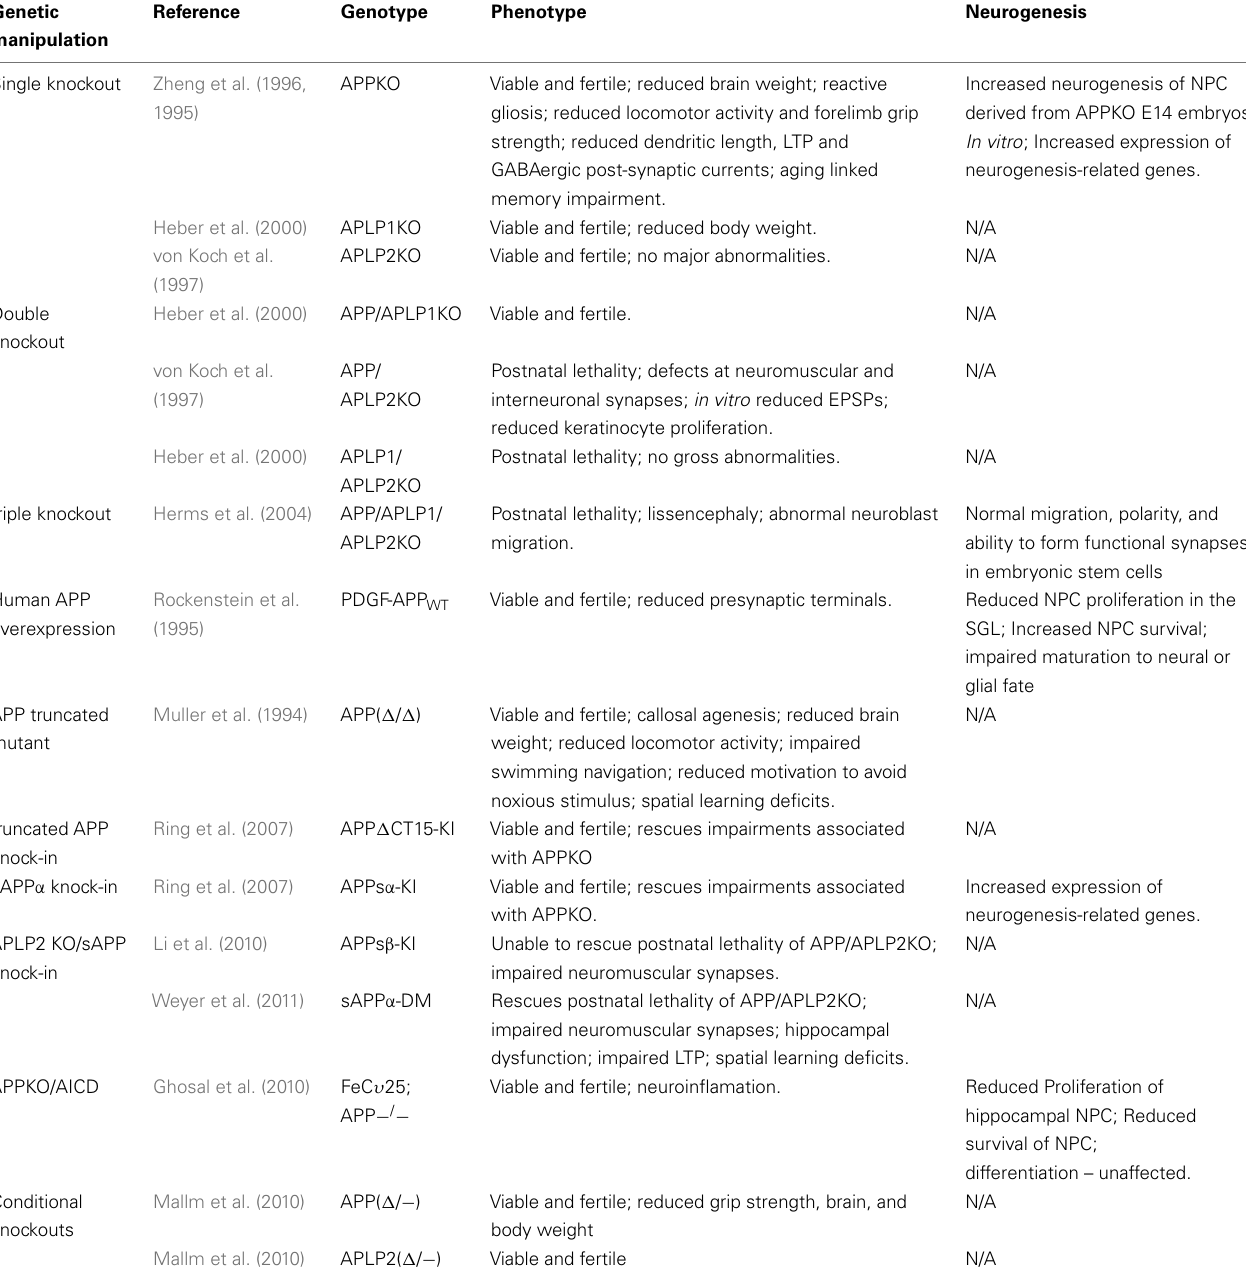
Table 2 |APP animal models and